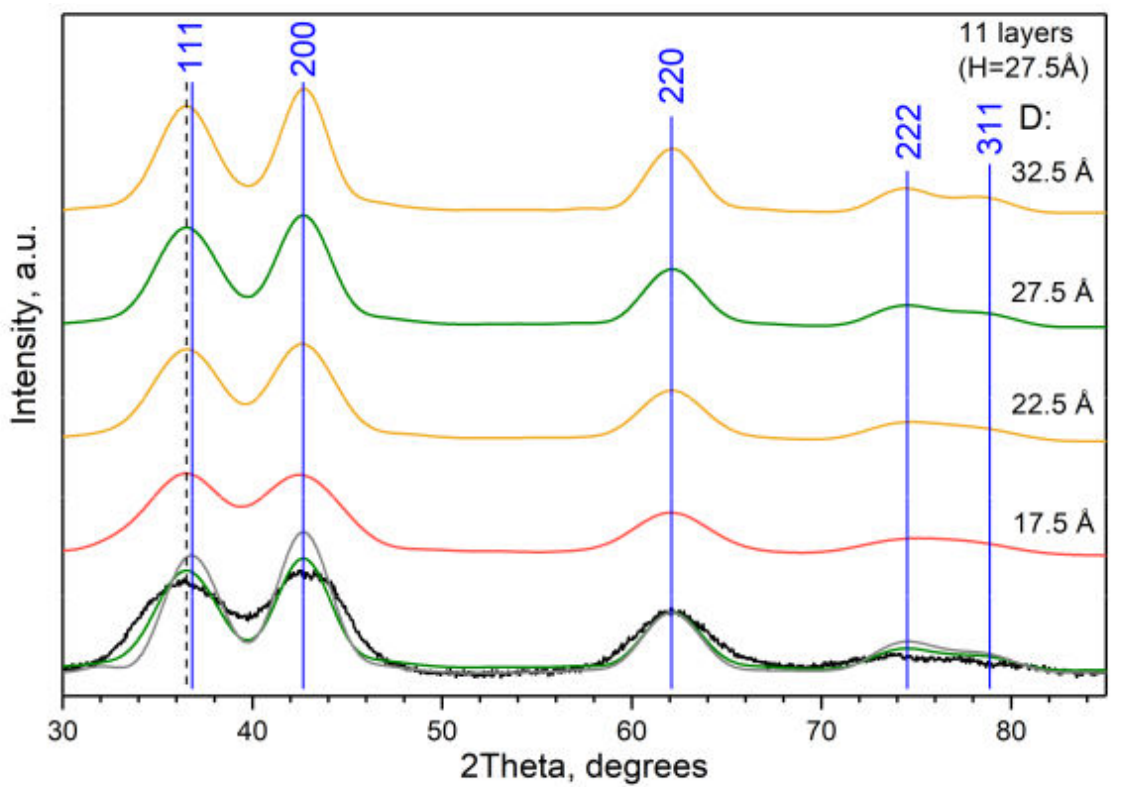
Figure 9. The partial experimental XRD pattern of mixed oxide (the black curve) obtained by subtraction of the XRD pattern calculated for NiO from the common experimental XRD pattern; XRD patterns calculated on the basis of different models of cylindrical particles (H the height, D the diameter). The fraction of Si 2 O 4 layers was fixed at α = 0.25 (color curves). Grey curve was calculated for α = 0.0 (NiO with a = 4.223 Å), H = D = 27.5 Å. Blue lines show the positions of peaks for NiO ( α = 0.0) with a = 4.223 Å. Dash line shows the position of the 111 peak at α =